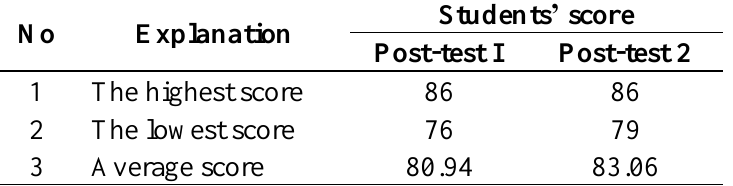
Table 3. The Comparison between the Score of Post Test 1 and Post Test